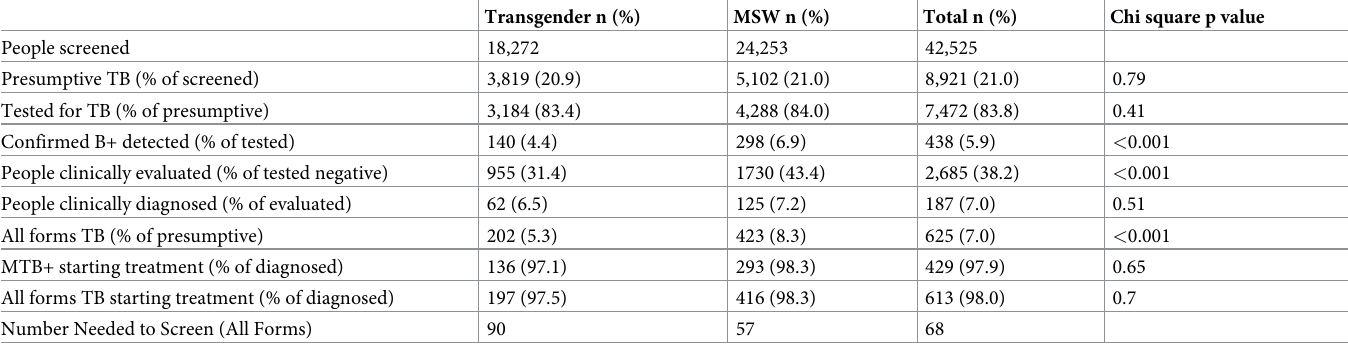
Table 1. TB screening cascade among transgender women and male sex workers.